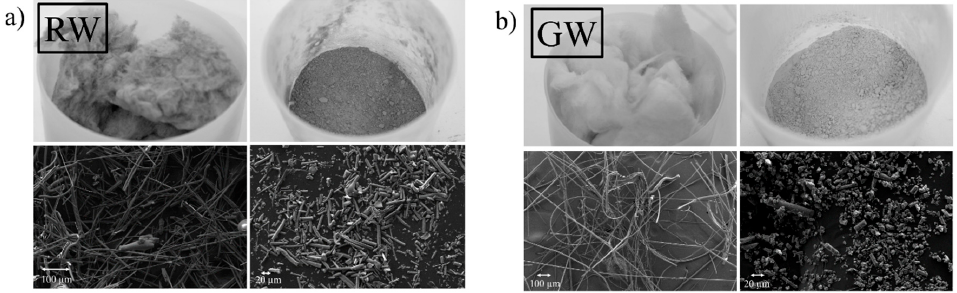
Figure 1. Photograph and FESEM images of ( a ) rock wool (RW); and ( b ) glass wool (GW) before and after grinding.